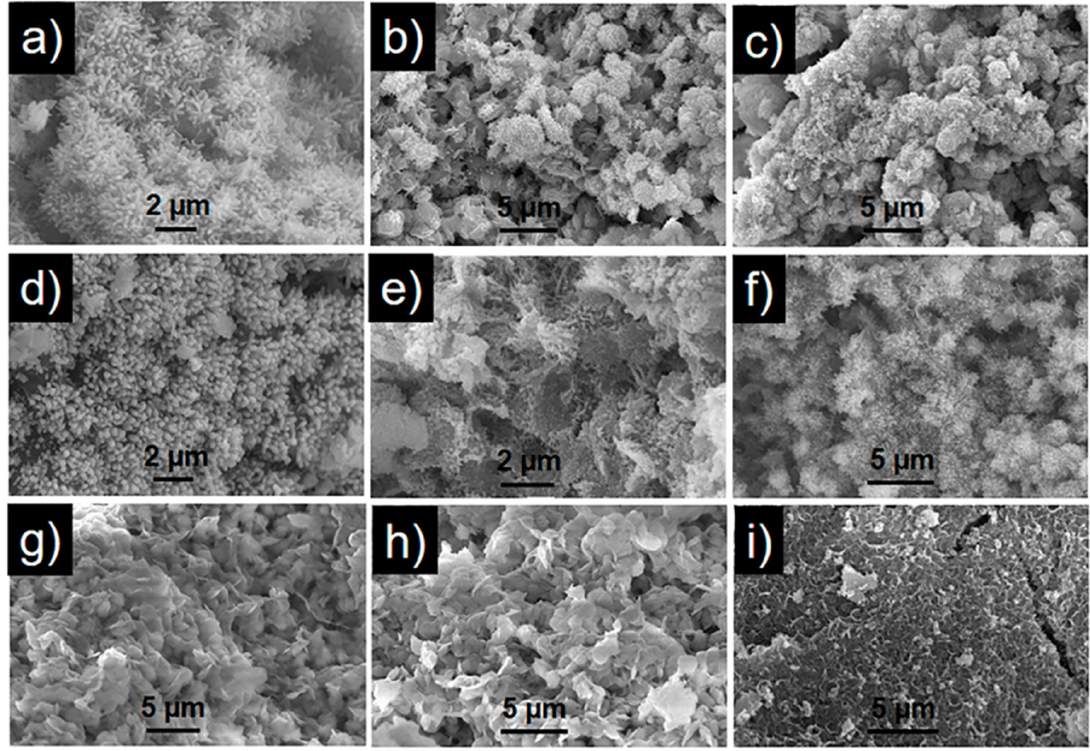
Figure 5. Typical SEM micrographs of ZnAl 2 O 4 powders obtained at temperatures: ( a ) 200, ( b ) 300, ( c ) 400, ( d ) 500, ( e ) 600, ( f ) 700, ( g ) 800, ( h ) 900, and ( i ) 1000 °C.